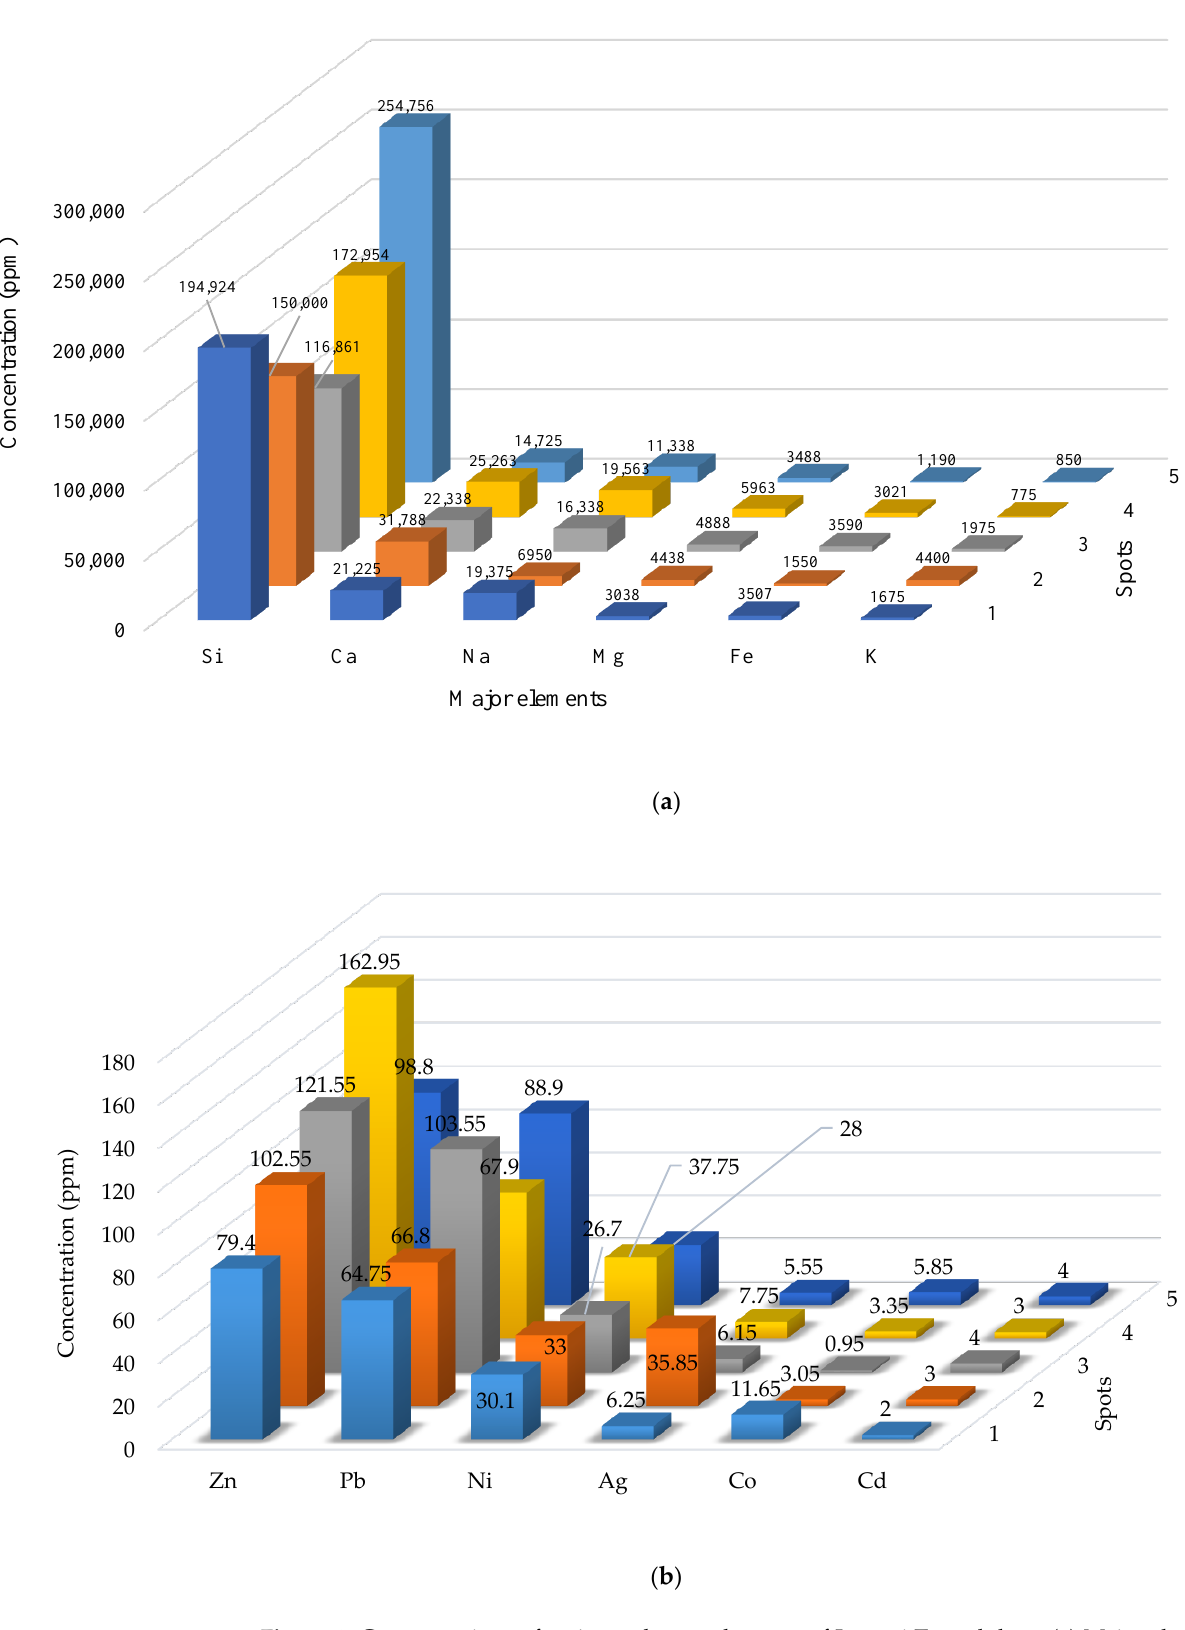
Figure 4. Concentrations of major and trace elements of Lowari Tunnel dust. ( a ) Major elements; ( b ) trace elements.